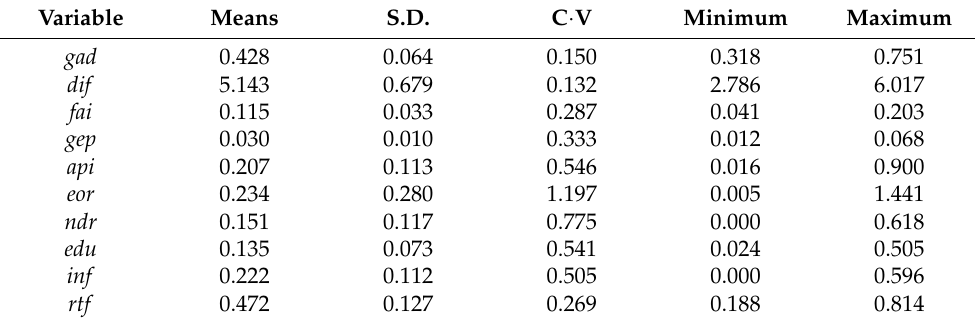
Table 2. Descriptive statistics of